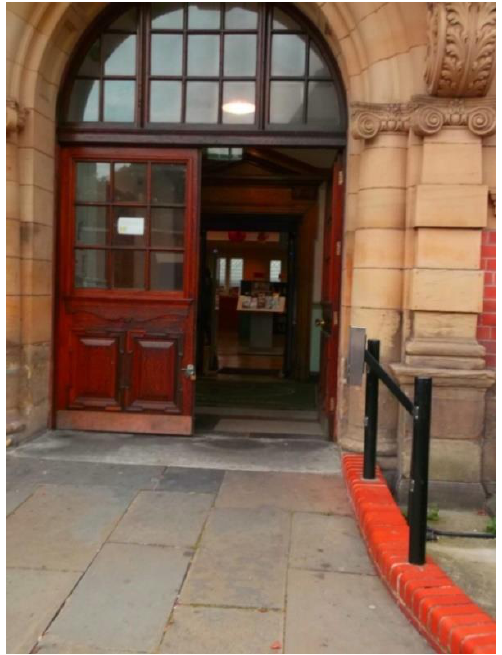
Figure 19. Example of libraries promoting respect and social inclusion (P2) (Toxteth Library, Liverpool).